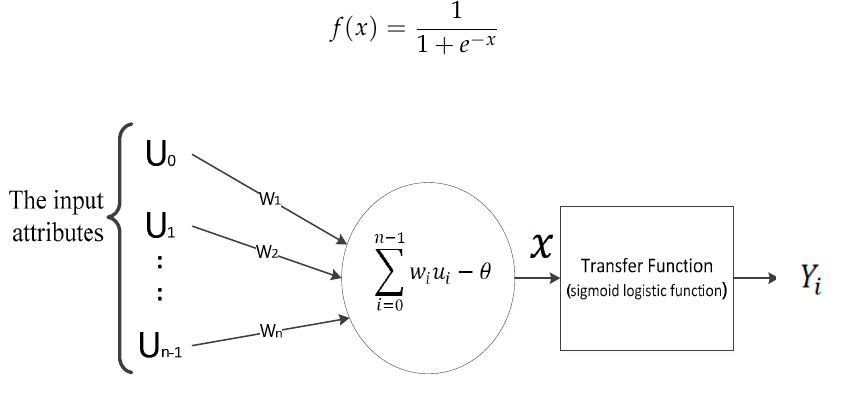
Figure 2. The behaviour of an artificial neuron.